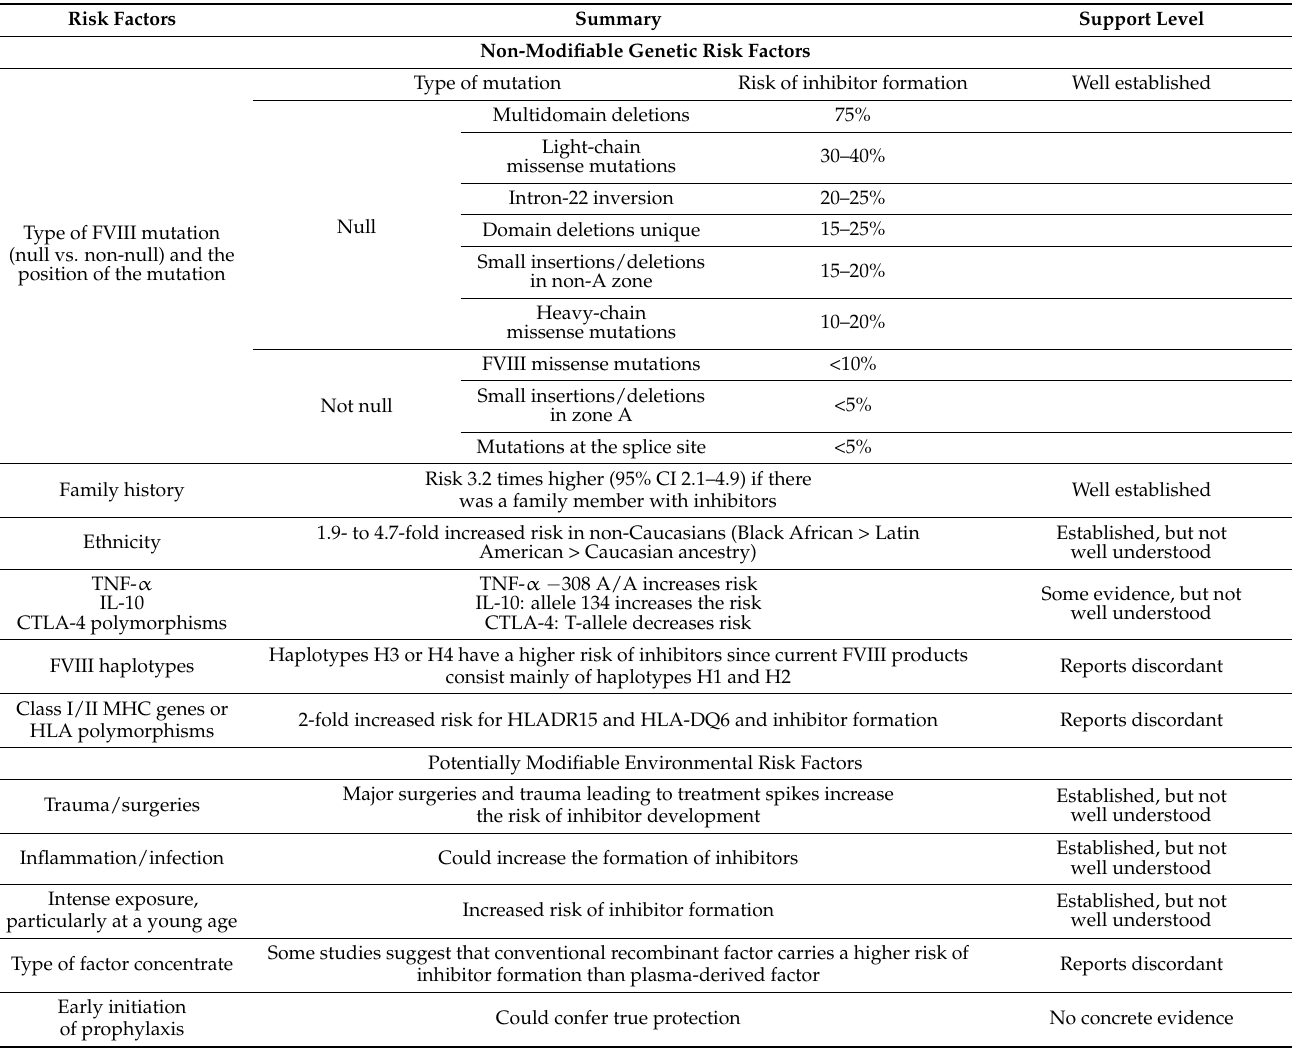
Table 1. Non-modifiable and possibly modifiable risk factors for inhibitor development. Taken from Carcao M, et al.